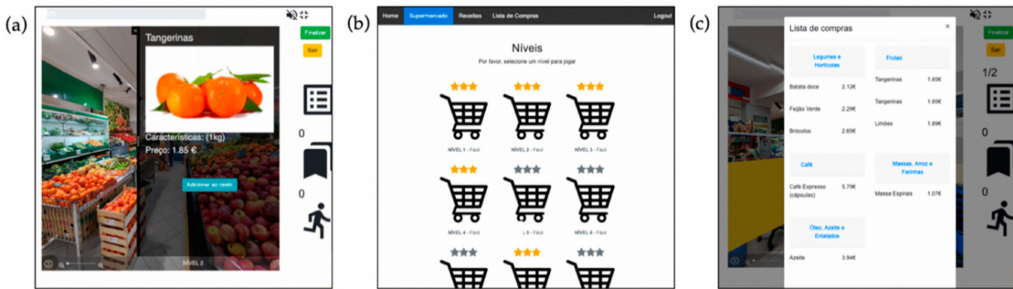
Figure 2. ( a ) Tag with product information—name, photo, description / weight, price, and add button; ( b ) view of the screen with the levels of di ffi culty, three-star classification, level ID, level of di ffi culty; ( c ) shopping list from a di ffi cult level (medium) with nine products (written in black) under the correspondent category (written in